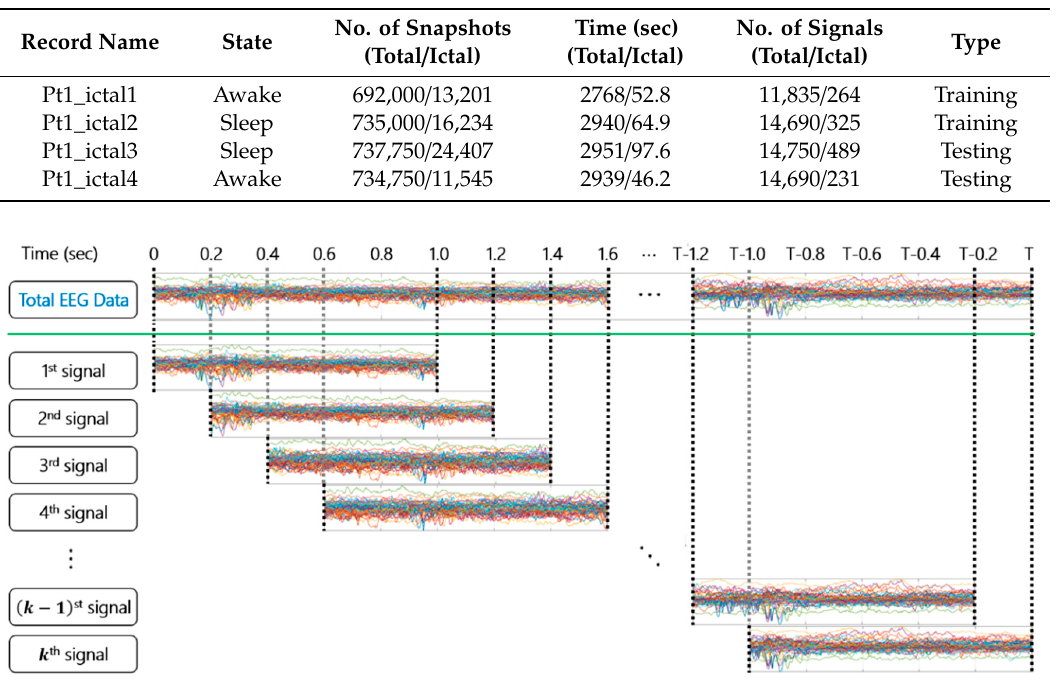
Table 1. Details of four epileptic ECoG recordings used in the dataset. The entire dataset was obtained from one patient. All of the recordings were resampled at 250 Hz (250 per second) and contain the spatial information of 49 channels for each snapshot. Each EEG signal corresponds to a matrix of one-second duration snapshots combined in the column direction, and it was collected every 0.2 s.